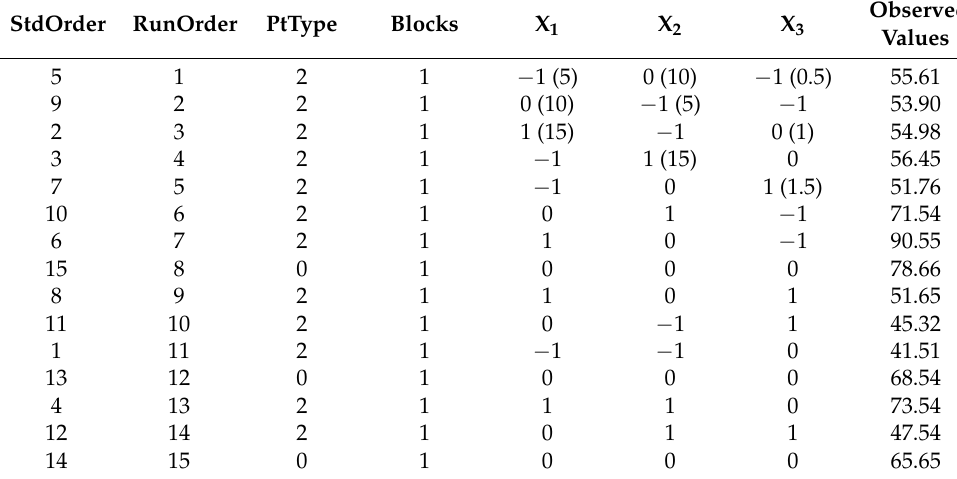
Table 1. Experimental design and results of optimization of nutrient medium for the production of secondary metabolites from BAM strain by the central composite